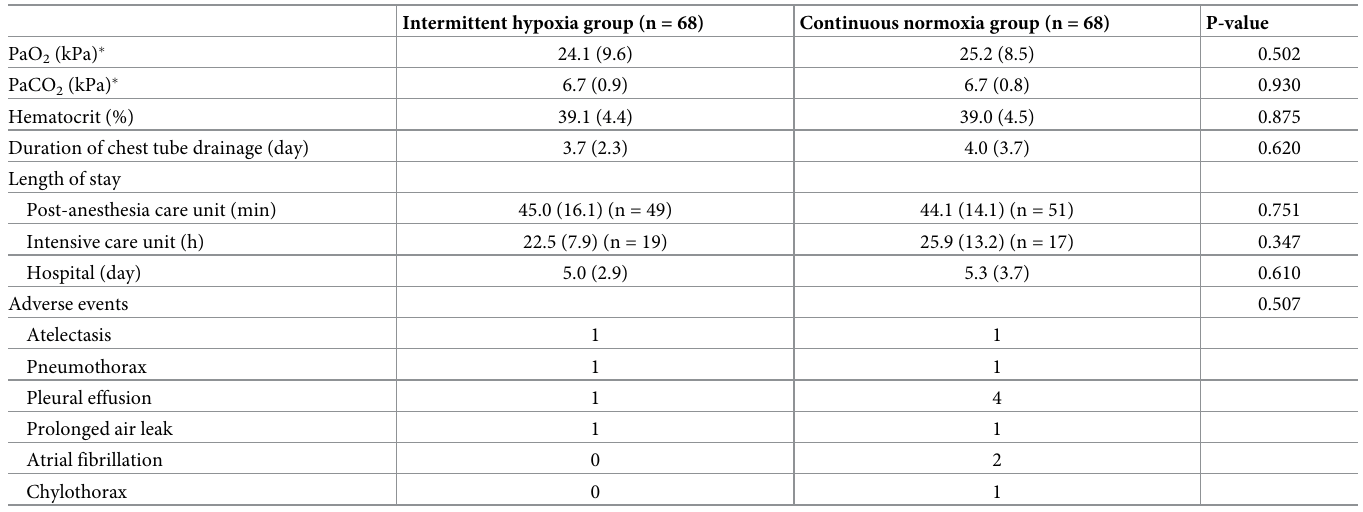
Table 2. Postoperative